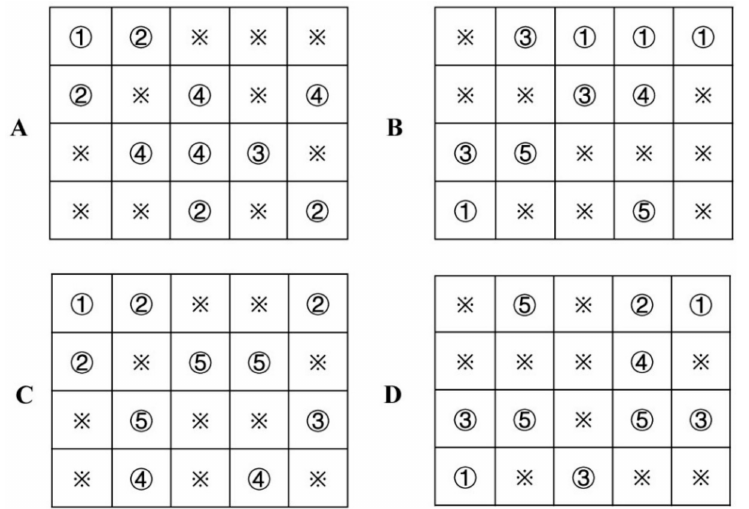
Figure 1. Mixed planting design of beech and fir seedlings in mesocosms ( A – D ). ※ , silver fir; circle with number, beech. The numbers of 1–5 indicate the number of silver fir neighbours to the respective beech